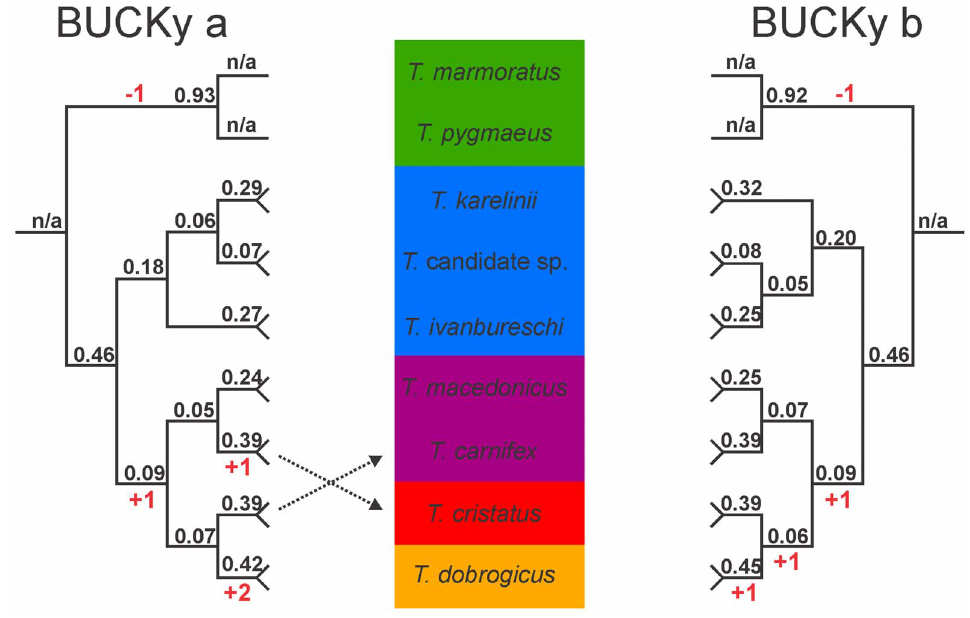
Figure 4. Primary concordance trees resulting from the Bayesian concordance analysis in BUCKy for the genus Triturus , based on 38 nuclear markers positioned in 3 9 untranslated regions, sequenced for 20 individuals. Support values represent concordance factors, i.e. the proportion of gene trees in which clades are present; n/a is not applicable. Relationships within species are not shown. Analyses a and b reflect two different input files used which, for heterozygote marker-individual combinations, include either one or the other allele. The inferred position of the root for Triturus is shown. Background colors reflect variation in the number of rib-bearing pre-sacral vertebrae characterizing Triturus morphotypes as in Fig. 1 and the character stage changes required are noted in red.